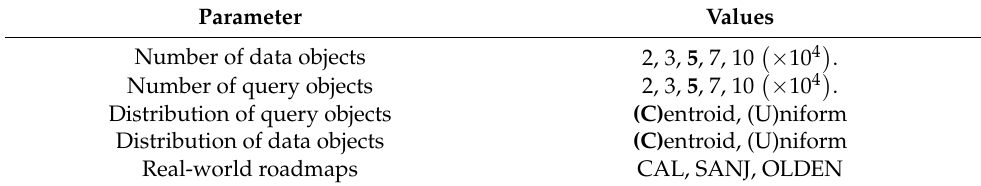
Table 5. Experimental